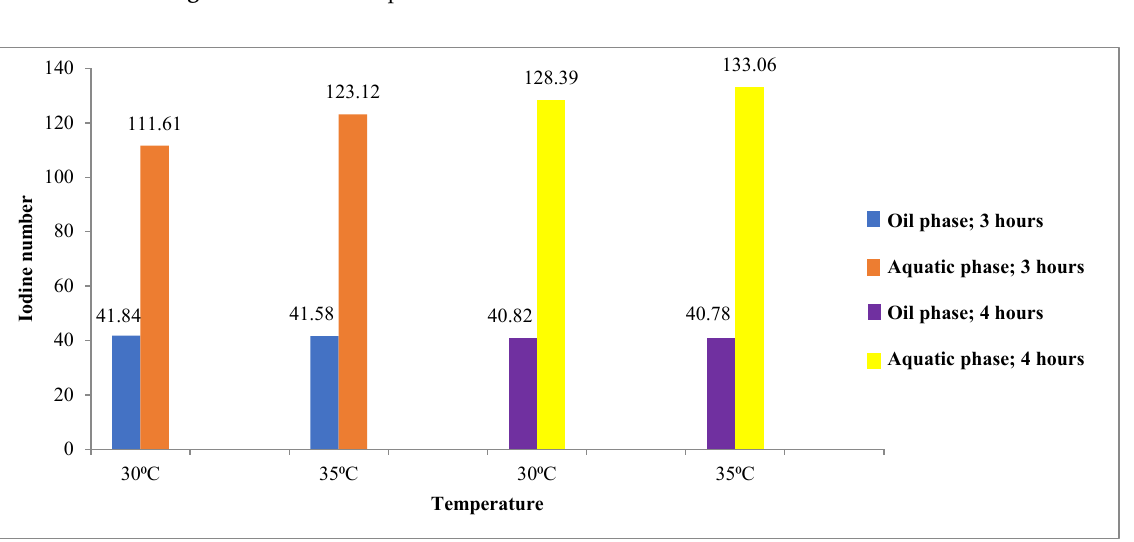
Figure 4. Effect of temperature and time on the iodine number at a ratio of 1:2.